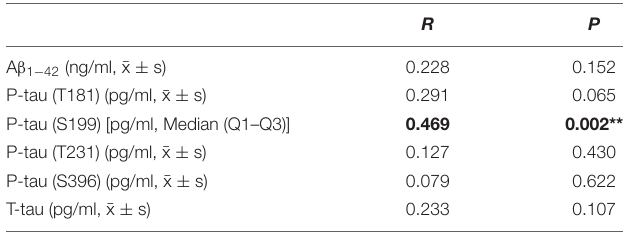
TABLE 5 | Correlations of PTA threshold with the levels of neuropathological biomarkers of AD in CSF from AD patients.